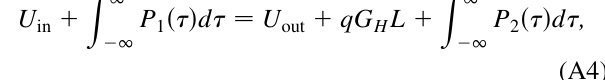
i (cid:1) 140 MeV = m and different values of the loss 0